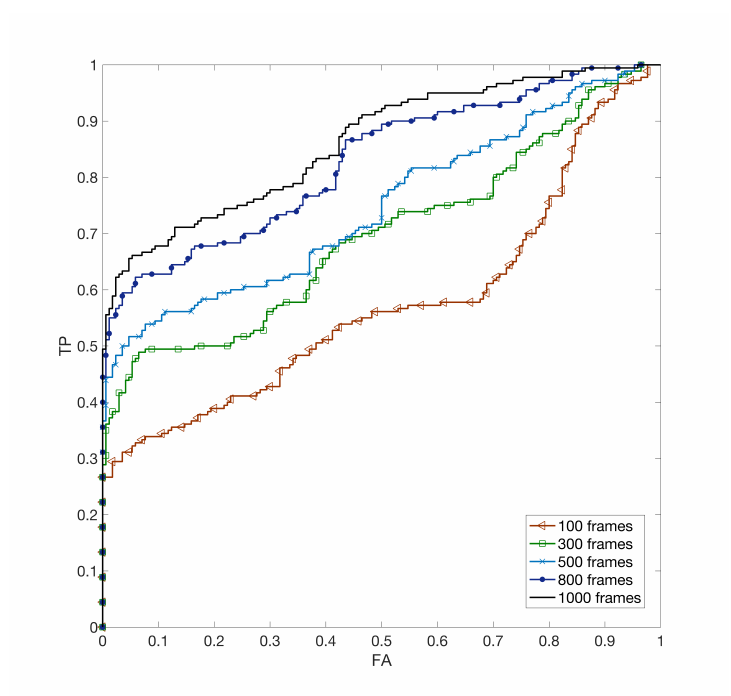
Figure 8. (Best viewed in color) ROC curves for profile linking between non-stabilized YouTube videos and Facebook low quality (LQ) images by varying the number of frames to estimate the video reference.